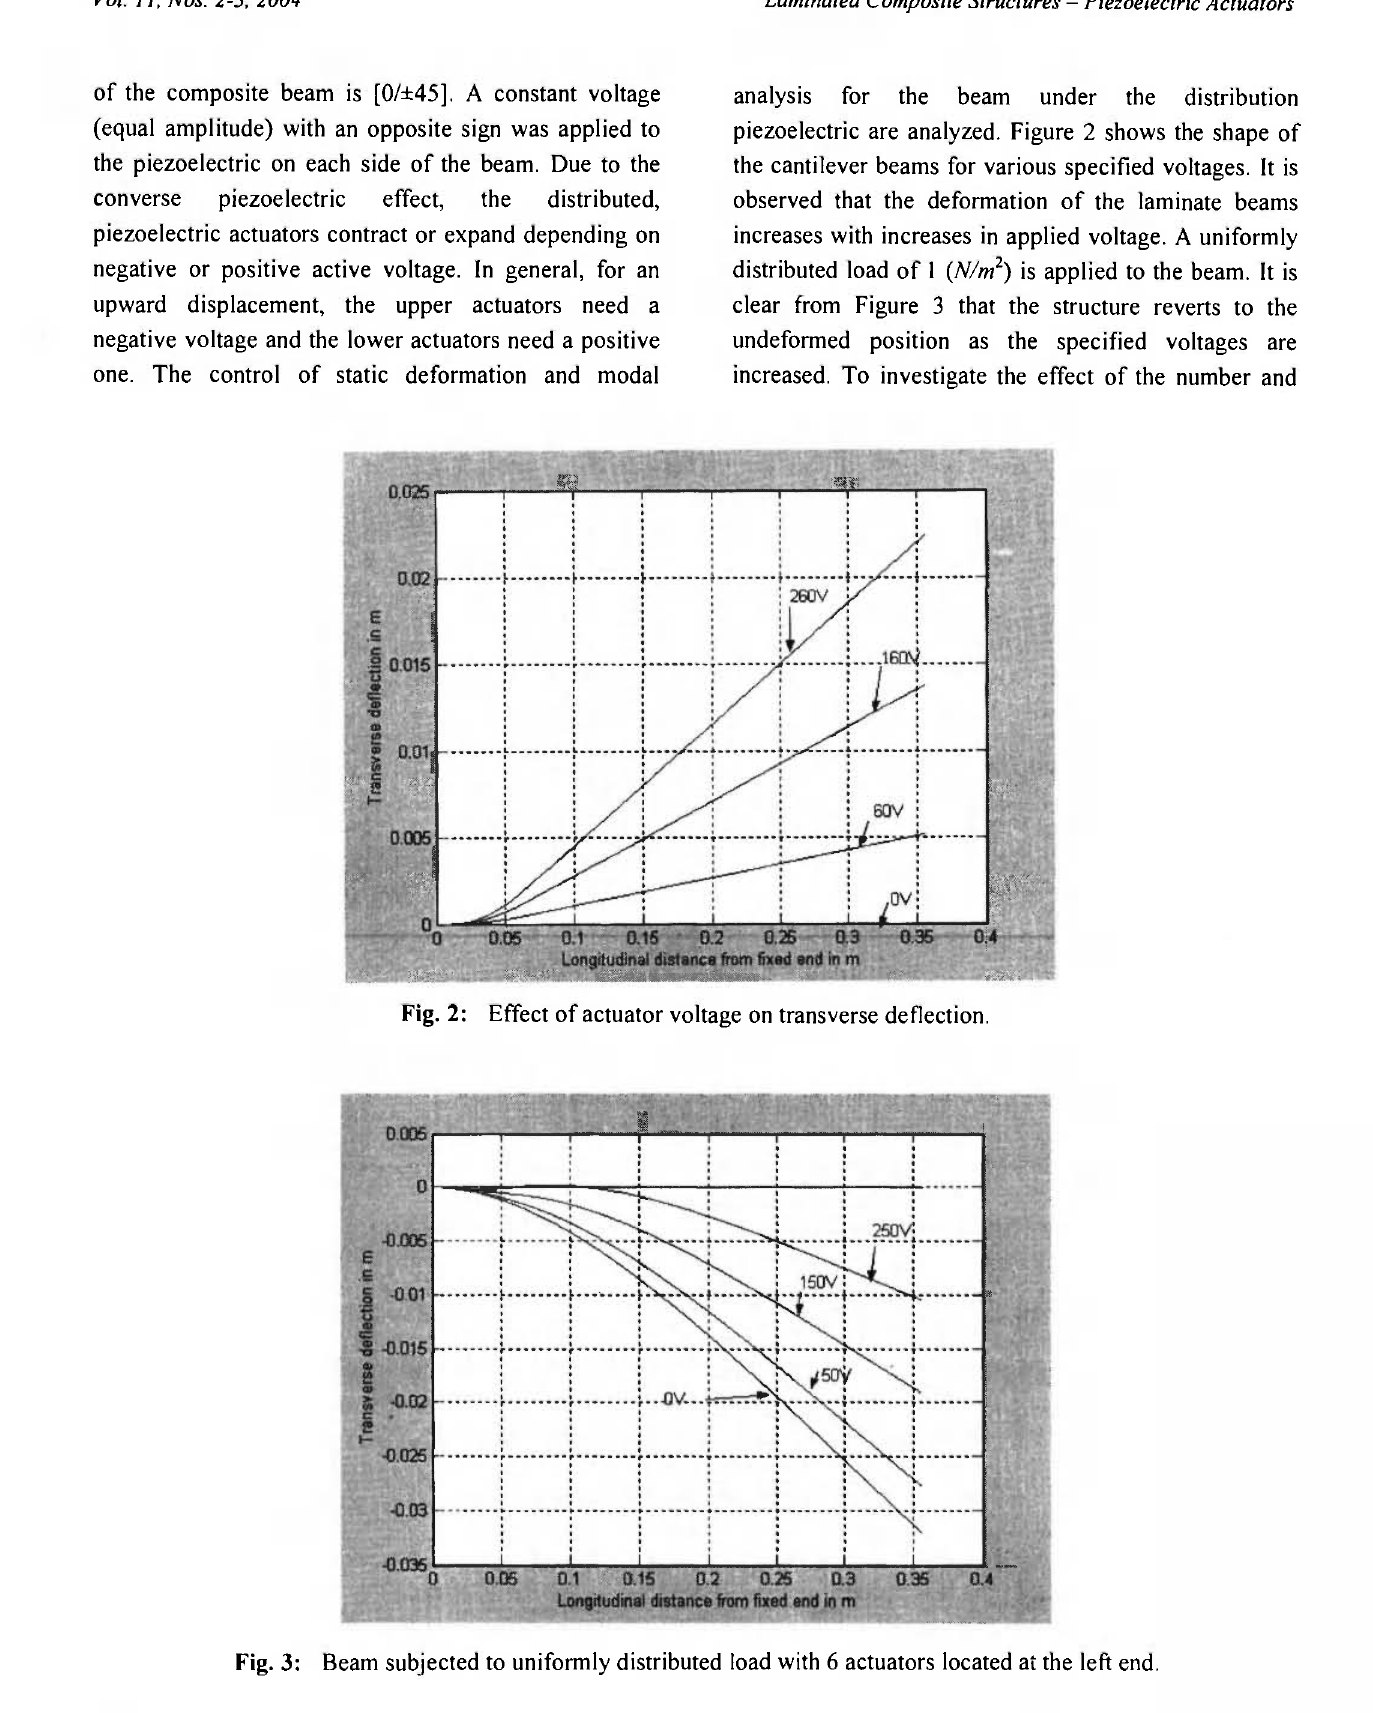
Fig. 2: Effect of actuator voltage on transverse deflection.